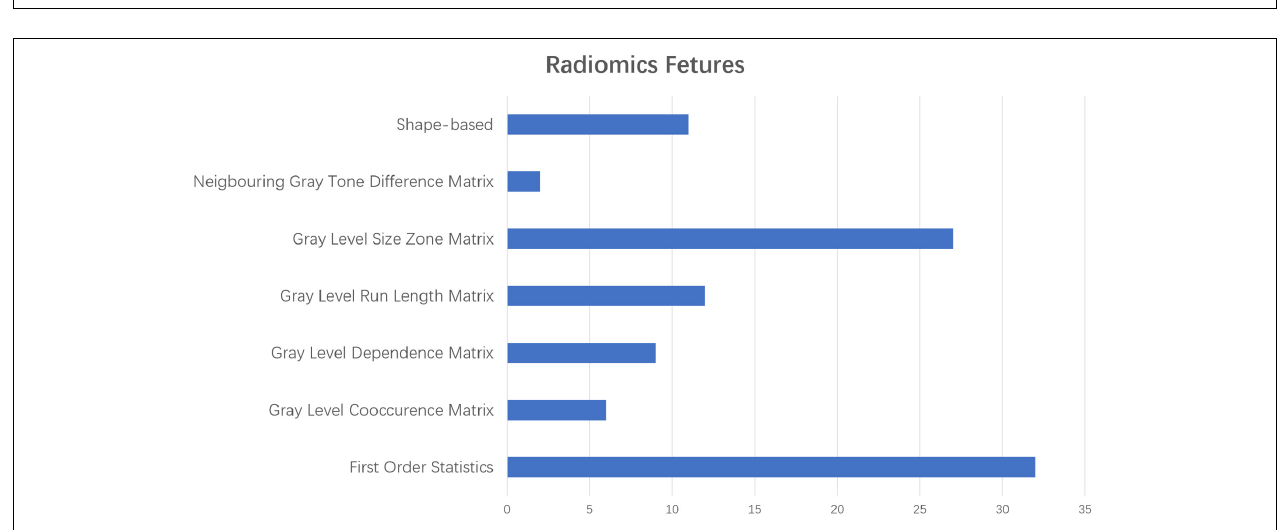
FIGURE 5 | The rad score in radiomics feature selection.